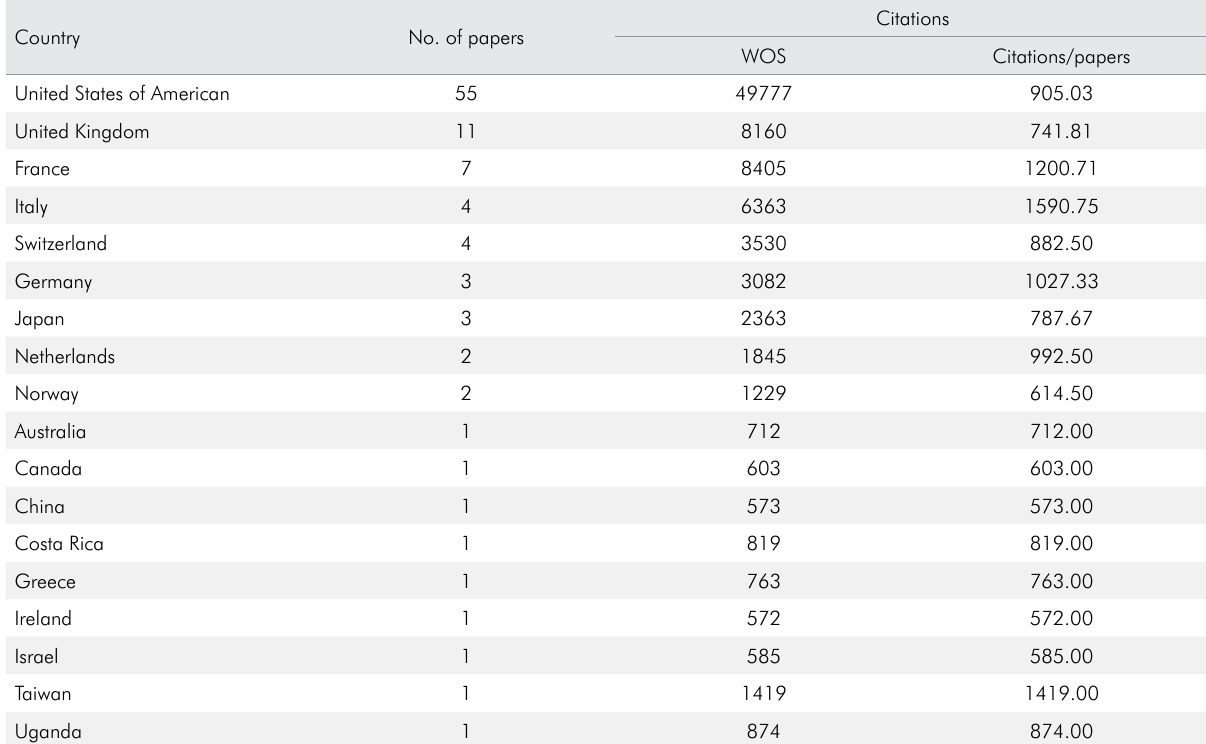
Table 3. The 18 countries of origin of the top-100 cited papers in pathology and oral medicine.